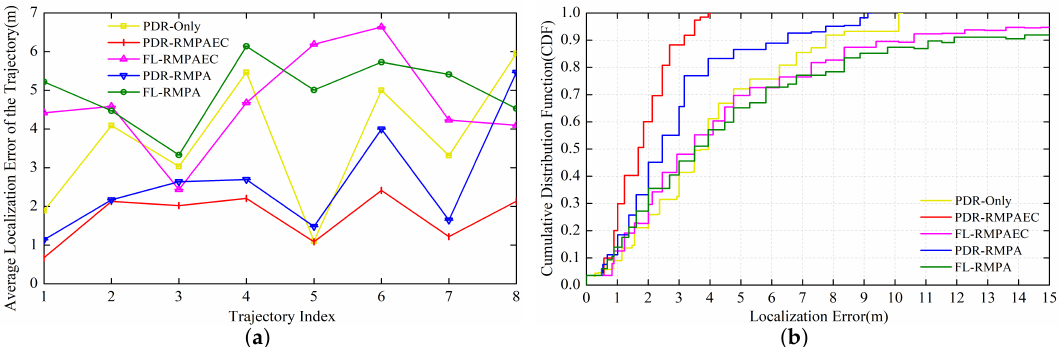
Figure 9. ( a ) ALE comparison between different methods of tracks on three routes in Experimental Area B; and ( b ) CDF of localization error of all the testing tracks in Experimental Area